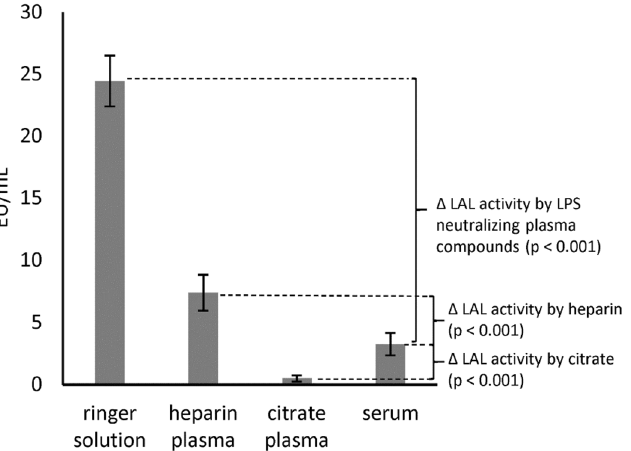
Figure 4. Comparison of LPS activity in aqueous solution, serum, heparin plasma and citrate plasma. 5 ng/mL LPS ( E. coli ) was spiked into ringer solution, human serum, heparin plasma and citrate plasma . The recovery of the added LPS into the different medium was determined by the LAL test. Mean ± standard deviation of three independent experiments with plasma/serum from different donors are